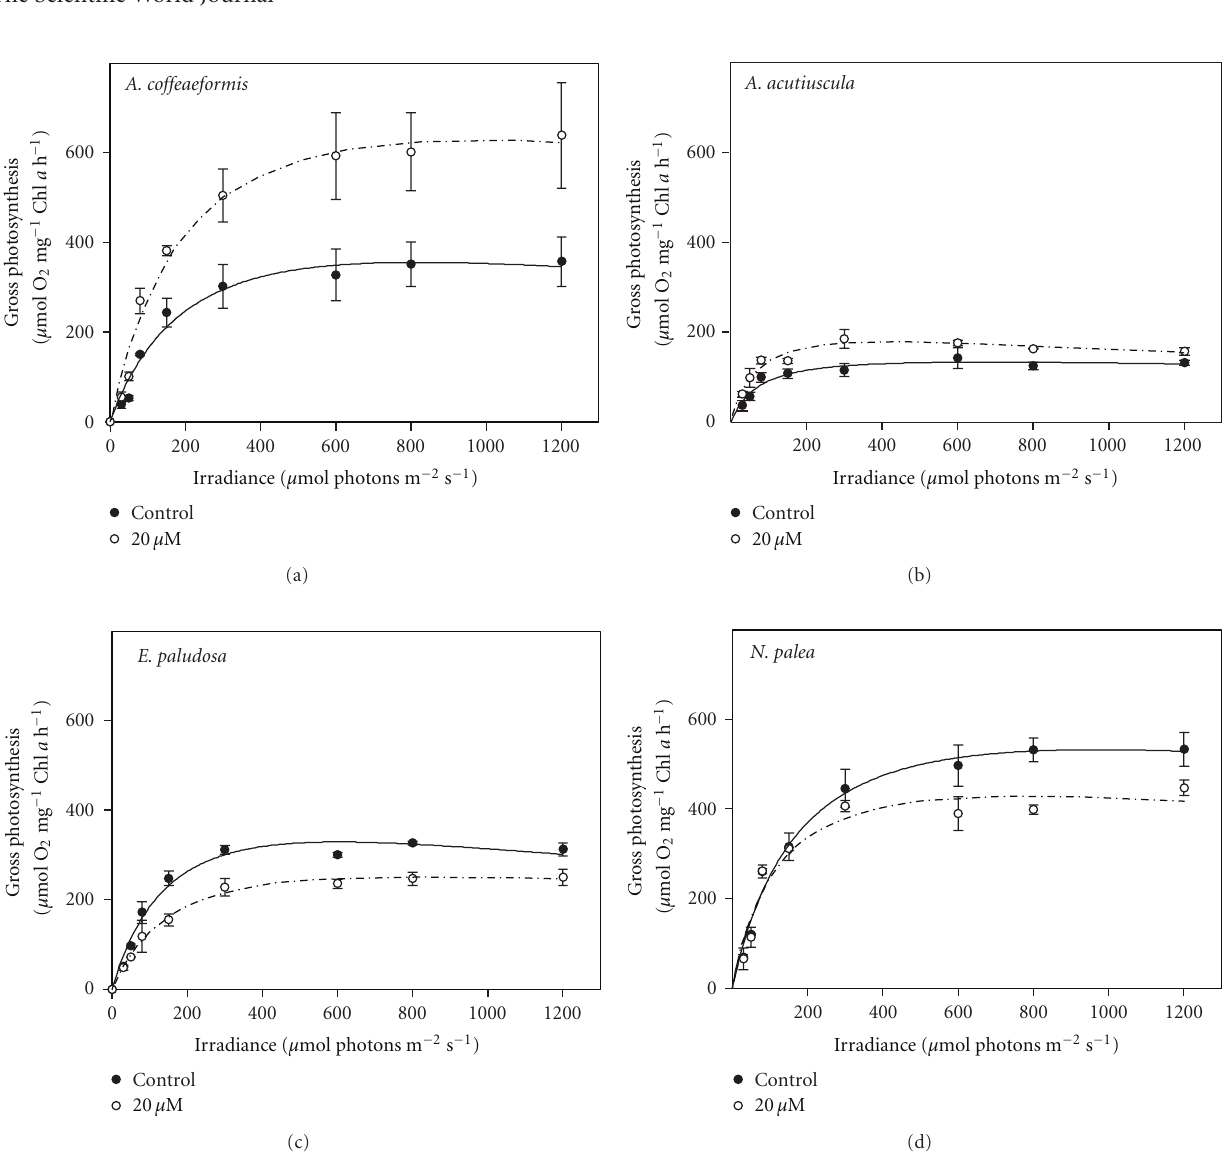
level at saturation . In the presence of Zn excess, the intensity of this parameter significantly increased in A. co ff eaeformis and E. paludosa, whereas it significantly decreased in the two other